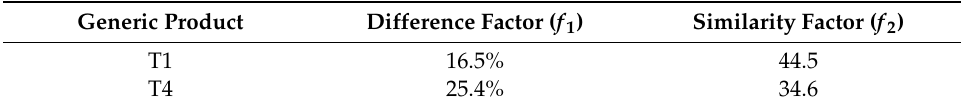
Table 4. Difference factor ( ƒ 1 ), similarity factor ( ƒ 2 ) and in vitro bioequivalence performances of five generic amoxicillin products in comparison to the reference product Augmentin ® .